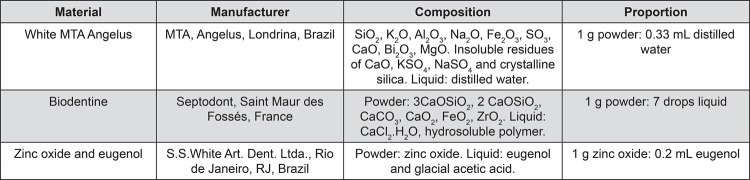
Root-end filling material, manufacturers, and proportions used